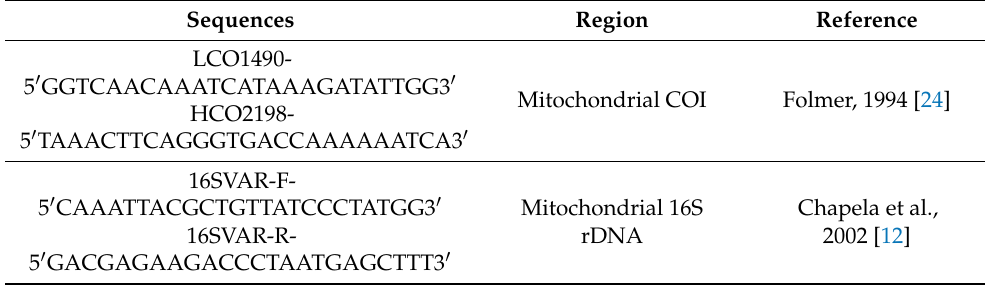
Table 3. Primers used for FINS authentication of all the samples.